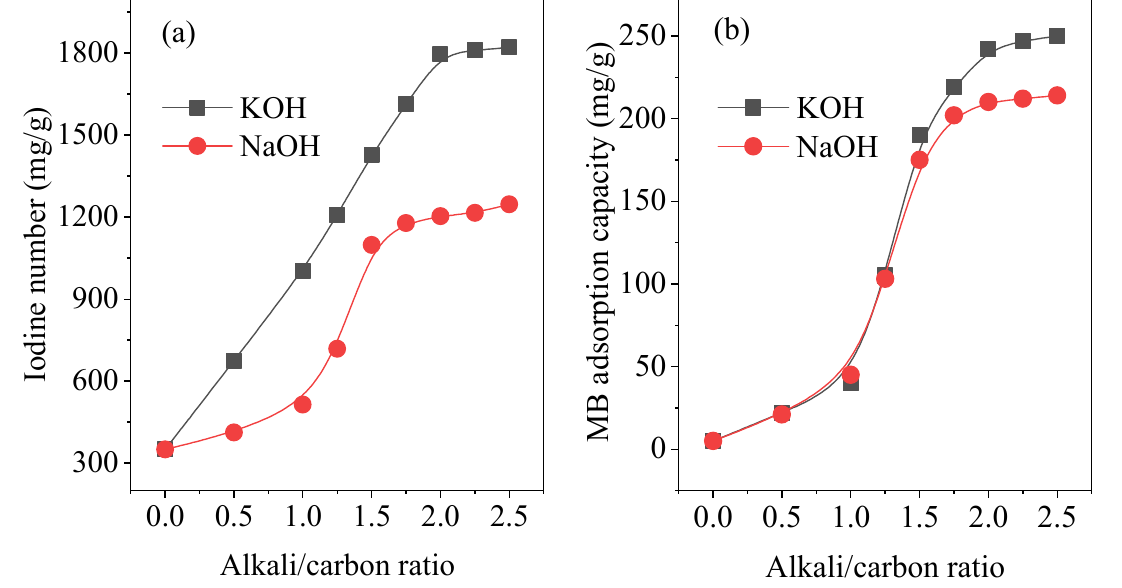
Figure 3. Effect of alkali/carbon ratio on the adsorption performance of activated carbon: ( a ) iodine number, and ( b ) MB adsorption capacity. Conditions: activation temperature 650 °C and impregnation time 48 h.